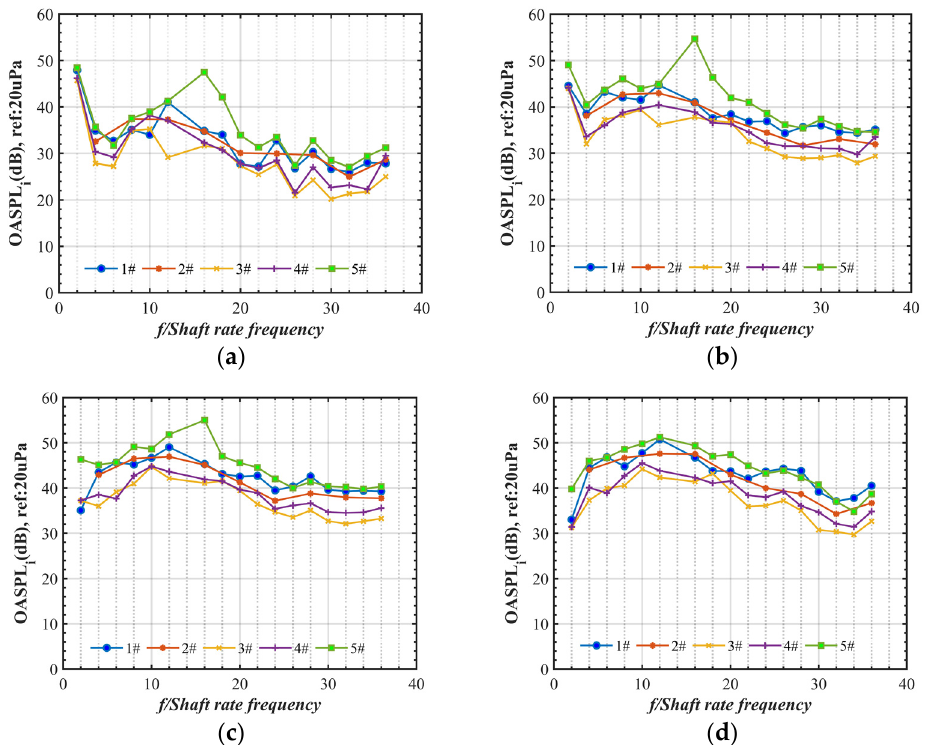
Figure 11. Comparison of the tonal noise, OASPL i ( i = 2, 4, . . . , 36 ) , below 5400 rpm at four locations of Mic 1 ( a ), Mic 2 ( b ), Mic 3 ( c ), and Mic 4 ( d ).